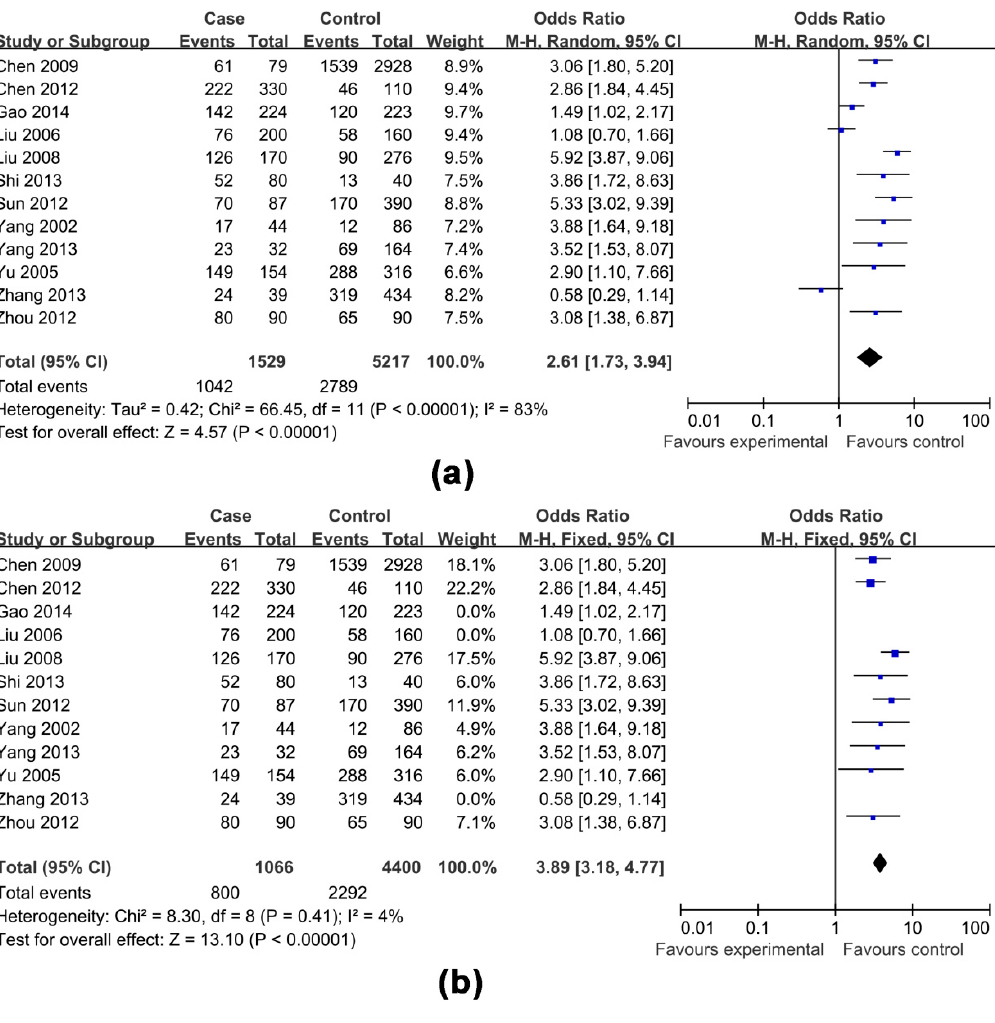
Figure 5. Effects of possible risk factors in chronic HBV-infected patients: ( a ) high HBV DNA levels; and ( b ) high HBV DNA levels adjusted.